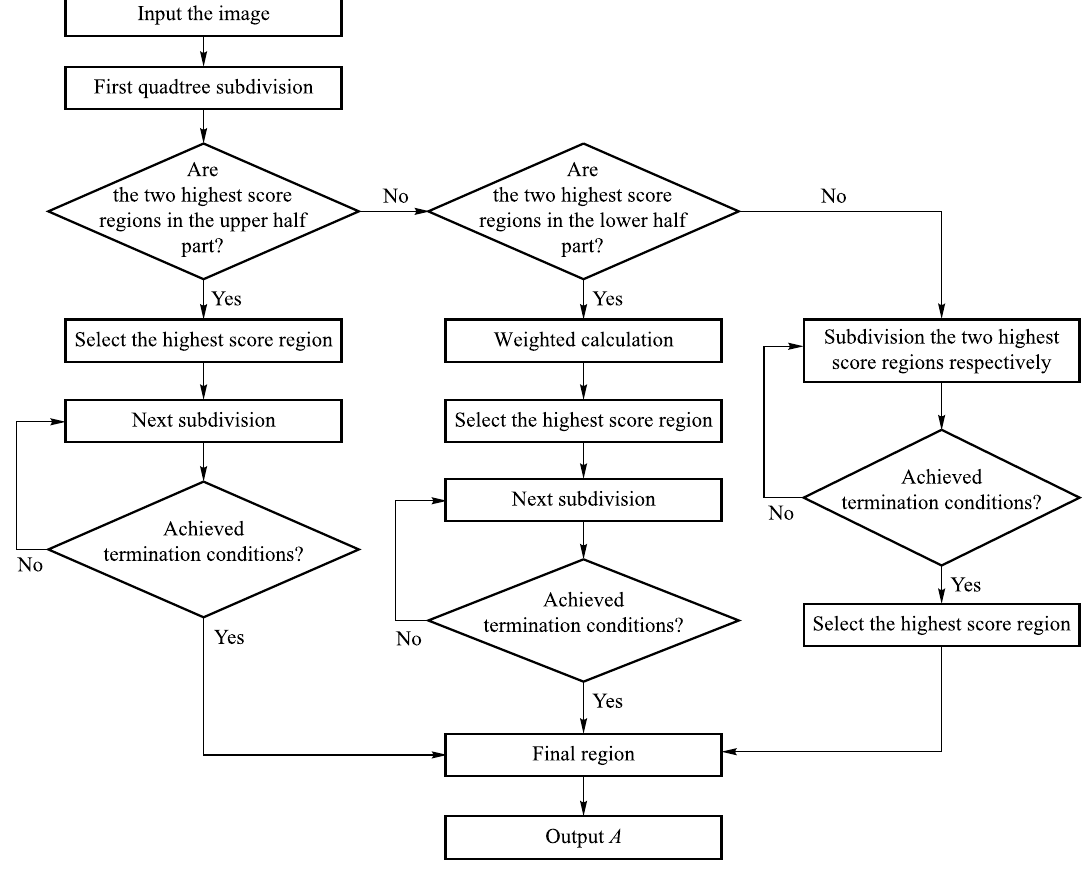
Fig. 3 Flowchart of multichannel quad-tree algorithm to estimate atmospheric light